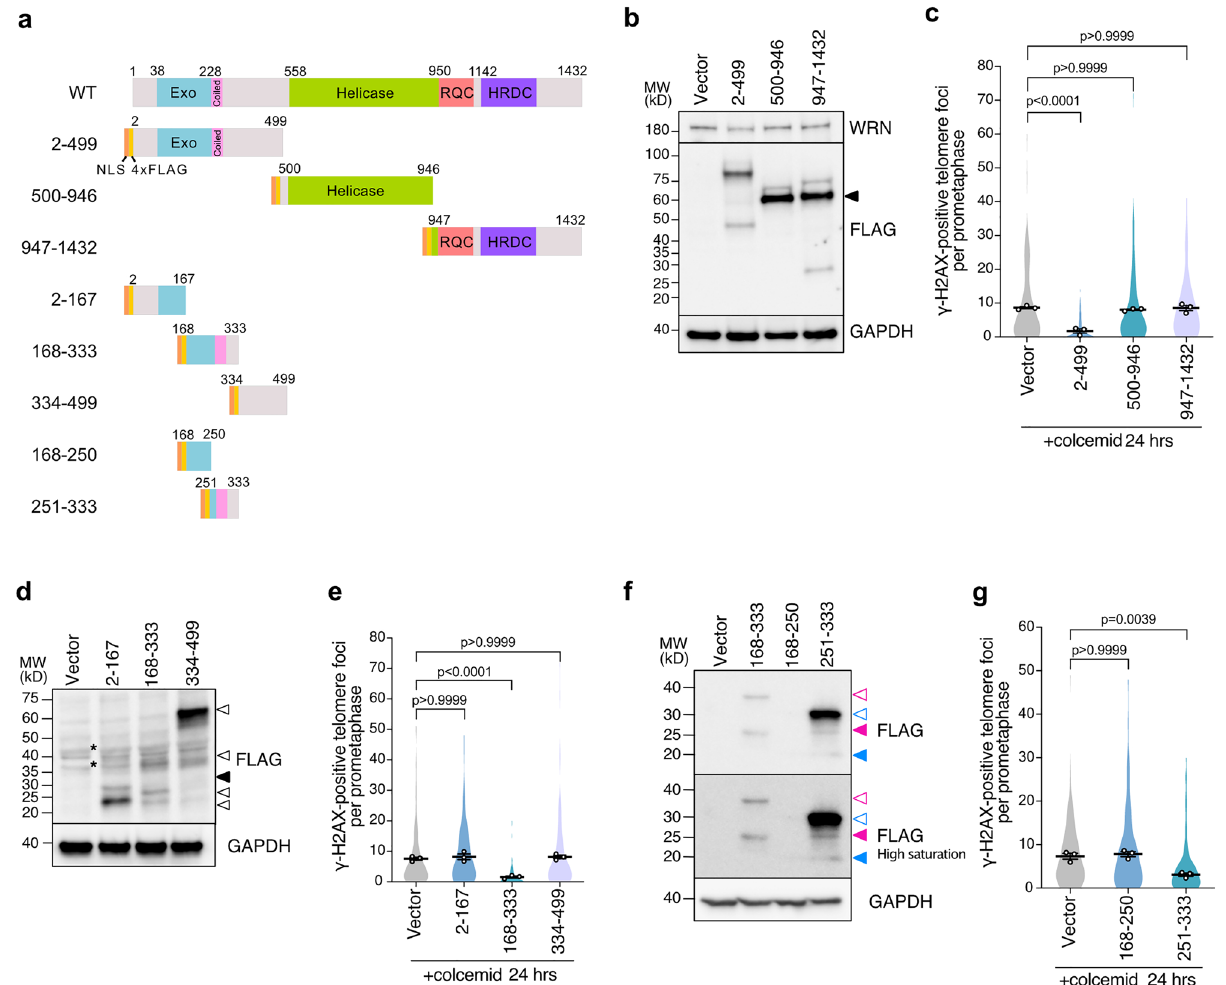
Figure 2. WRN N-terminus coiled-coil region is sufficient to suppress MAD-TIFs. ( a ) Schematic representation of NLS and 4xFLAG tagged WRN fragments and derivative sub-fragments from the N-terminal WRN 2–499 fragment. Exo, exonuclease domain; Coiled, coiled-coil motif; Helicase, helicase domain; RQC, RecQ C-terminal DNA-binding domain; HRDC, helicase and RNaseD C-terminal domain. ( b ) Immunoblot of endogenous WRN and NLS-4FL-WRN fragments in IMR-90 E6E7 hTERT cells expressing indicated WRN fragments. Transduced cells were analyzed on day 10 post-infection. A black arrowhead indicates bands of the expected size of 60–70 kDa. GAPDH serves as a loading control. ( c ) Quantification of telomeric signals colocalized with γ-H2AX foci in indicated conditions as shown in Fig. 1c (n = 30/experiment; mean ± s.e.m.; Kruskal–Wallis followed by Dunn’s test). ( d ) Immunoblot of FLAG-WRN fragments in IMR-90 E6E7 hTERT cells expressing indicated WRN fragments. Transduced cells were harvested on day 12 post-infection. A black arrowhead indicates the expected fragment size (~ 27 kDa). Potential truncation, complex formation, and post-translational modifications are specified with white arrowheads. Asterisks represent unspecific bands from empty Vector. GAPDH serves as a loading control. ( e ) Quantification of telomeric signals colocalized with γ-H2AX foci in indicated conditions as shown in Fig. 1c (n = 30/experiment; mean ± s.e.m.; Kruskal–Wallis followed by Dunn’s test). ( f ) Immunoblot of FLAG-WRN fragments in IMR-90 E6E7 hTERT cells expressing indicated WRN fragments. Transduced cells were harvested on day 12 post-infection. Magenta and blue arrowheads indicate the expected size for the WRN168-333 (~ 27 kDa) and the WRN251-333 (~ 17 kDa) fragments, respectively. White arrowheads with colored lines indicate possible post-translational modifications or complex formation for each mutant. ( g ) Quantification of telomeric signals colocalized with γ-H2AX foci in indicated conditions as shown in Fig. 1c (n = 30/experiment; mean ± s.e.m.; Kruskal–Wallis followed by Dunn’s test). Unprocessed blot images are shown in Supplementary Information